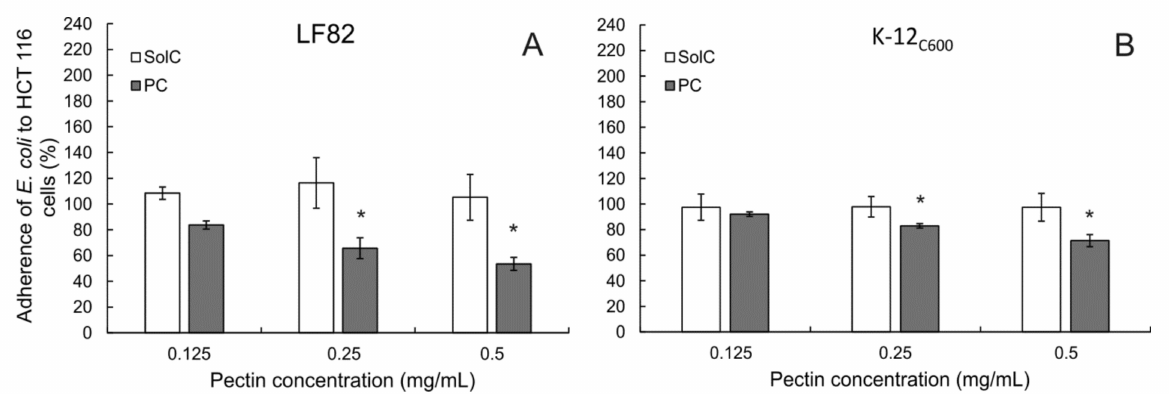
Figure 7. E. coli LH82 ( A ) and K-12 C600 strains ( B ) adherence to HCT 116 cells in the presence of pectins during 2 h of incubation. The means of three experiments ± SD are presented. Statistical significance (* p < 0.05) was checked between the studied probes and controls (no pectin) assumed to be